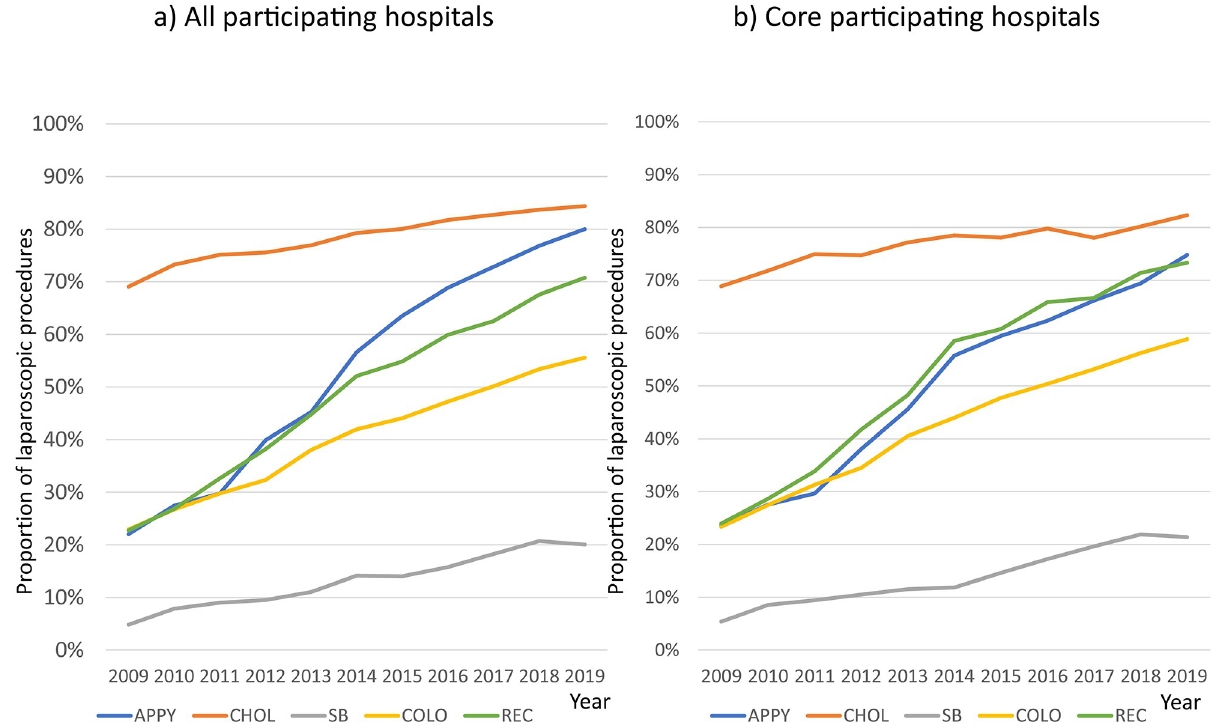
Fig 2. Proportion of laparoscopic procedures for each of the five digestive surgeries. a) Proportions of laparoscopic procedures for the five digestive surgeries in all participating hospitals. b) Proportions of laparoscopic procedures for the five digestive surgeries in the core participating hospitals The blue line indicates the rates for APPY. The orange line shows the rates of laparoscopic procedures performed for CHOL. The grey line shows the rates for SB. The yellow line shows the rates for COLO. The green line shows the rates for REC.